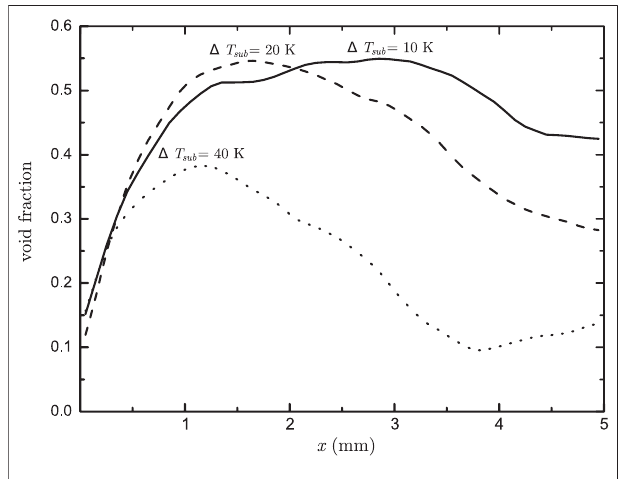
FIGURE 16 | Local pro fi le of void fraction at y (cid:2) 30 mm under various inlet